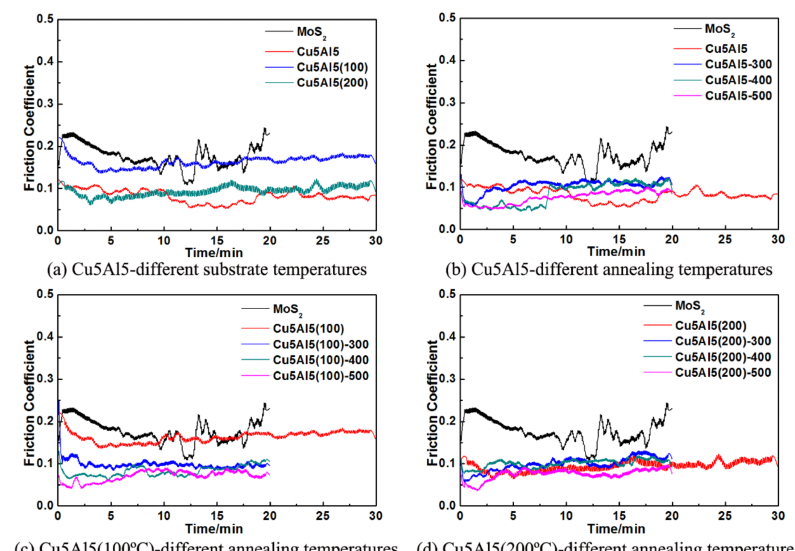
Figure 6. Friction coefficients of the Cu5Al5 composite coatings at various heat treatment temperatures.